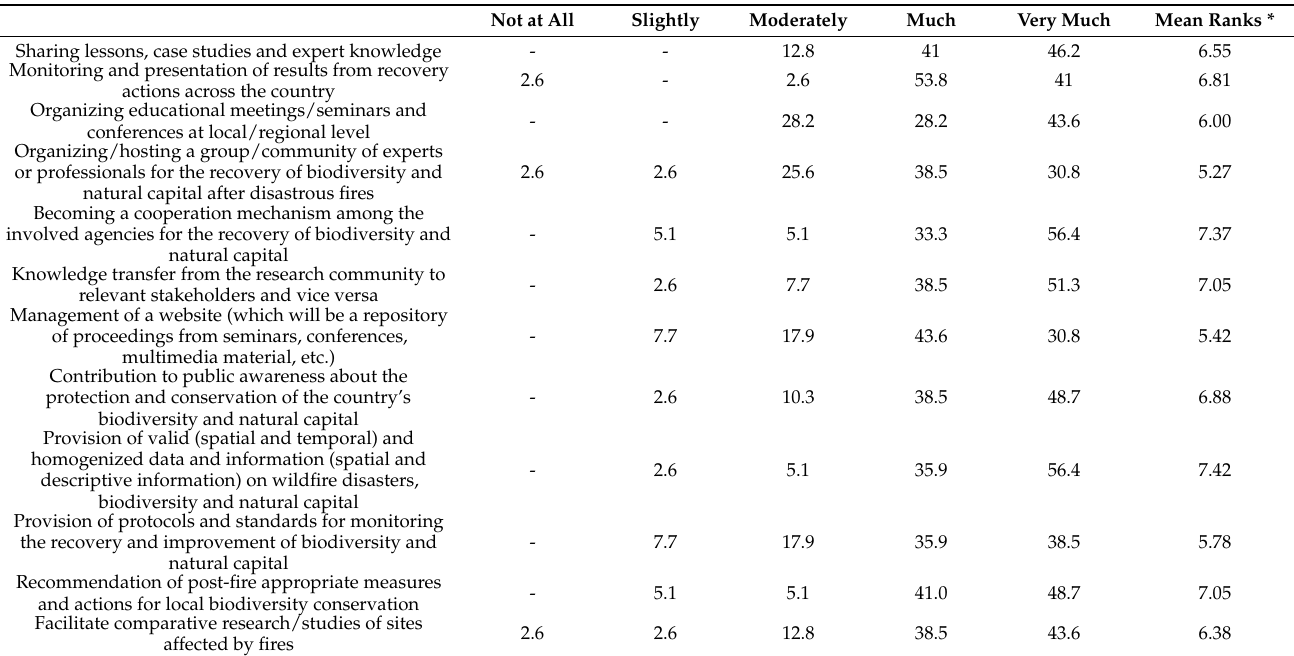
Table 15. Percentage units and differences among responses for the functions that the Hub should serve. Not at